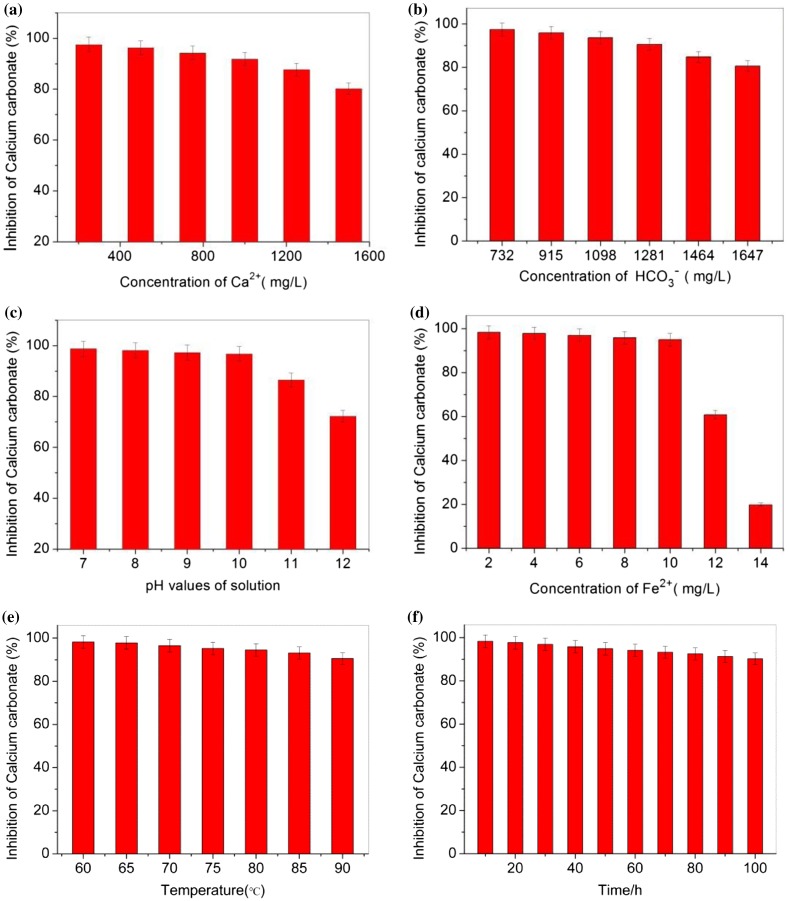
Inhibition at a level of 8 mg/L MA/APEG-PG-(OH)5 as a function of solution Ca2+ concentration (a), HCO3
− concentration (b), pH (c), Fe2+ concentration (d), Temperature (e) and Time (f).